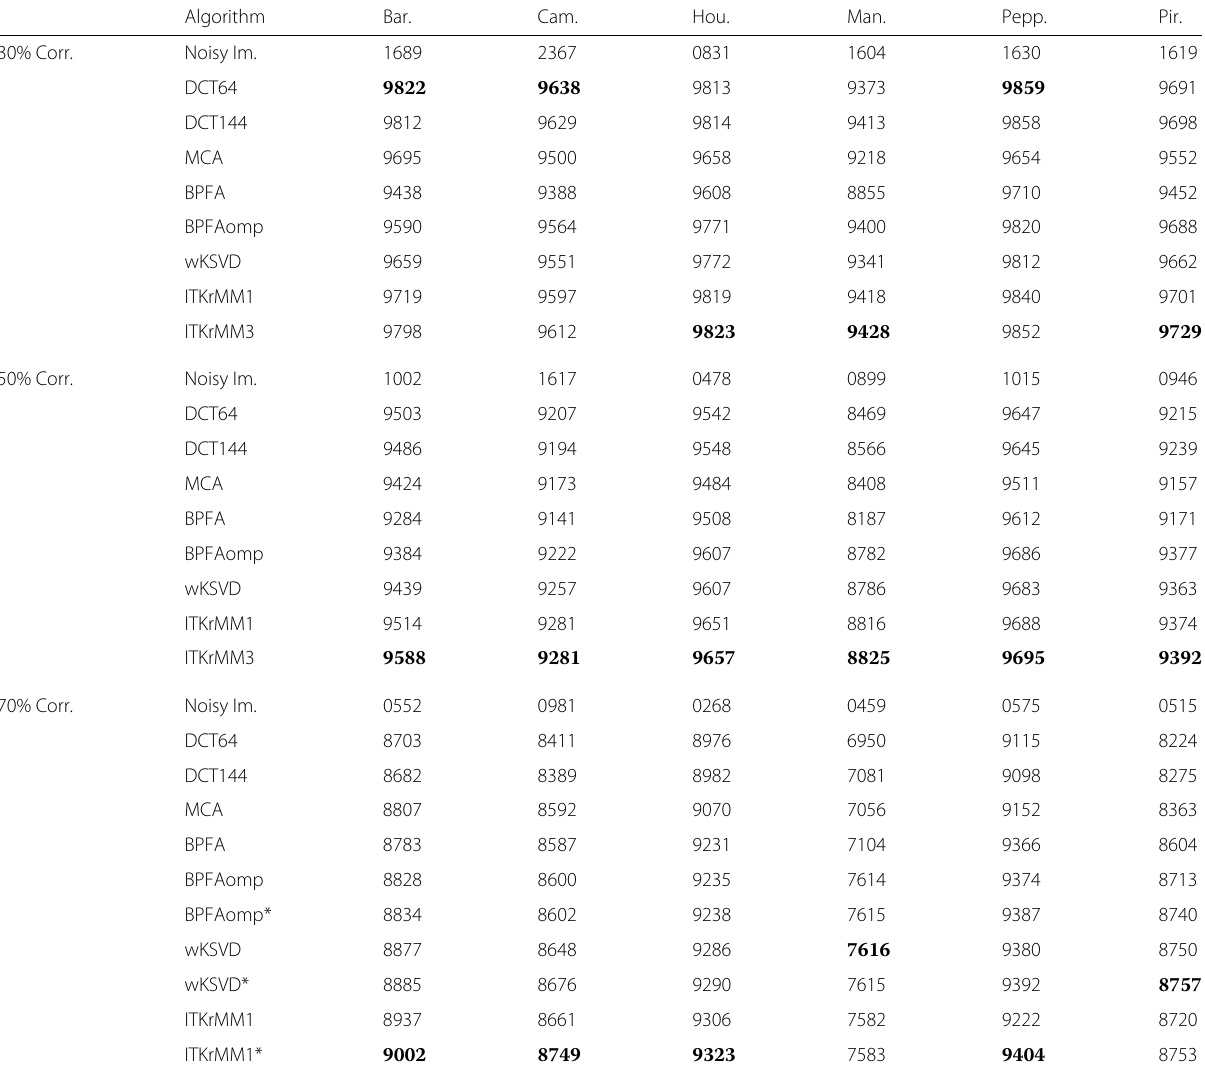
Table 5 Comparison of the SSIM value (0. − ) for inpainting of images with various corruption levels based on analytic dictionaries, DCT and MCA, and dictionaries learned on all available corrupted image patches, BPFA, BPFAomp, wKSVD and ITKrMM (modified inpainting is marked with a *) Algorithm Bar. Cam. Hou. Man. Pepp. Pir. 30% Corr. Noisy Im. 1689 2367